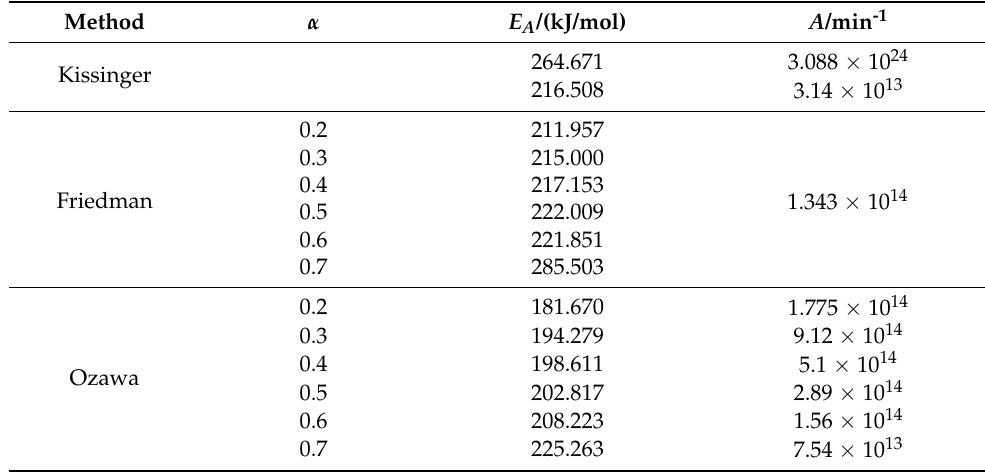
Table 1. Kinetic parameters by Kissinger, Friedman and Ozawa